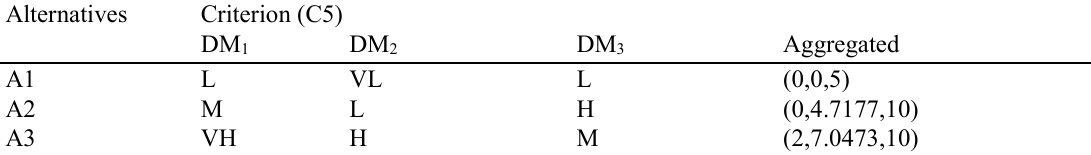
Table 3 Expert assessment for evaluating alternatives with respect to subjective criteria using linguistic variables.